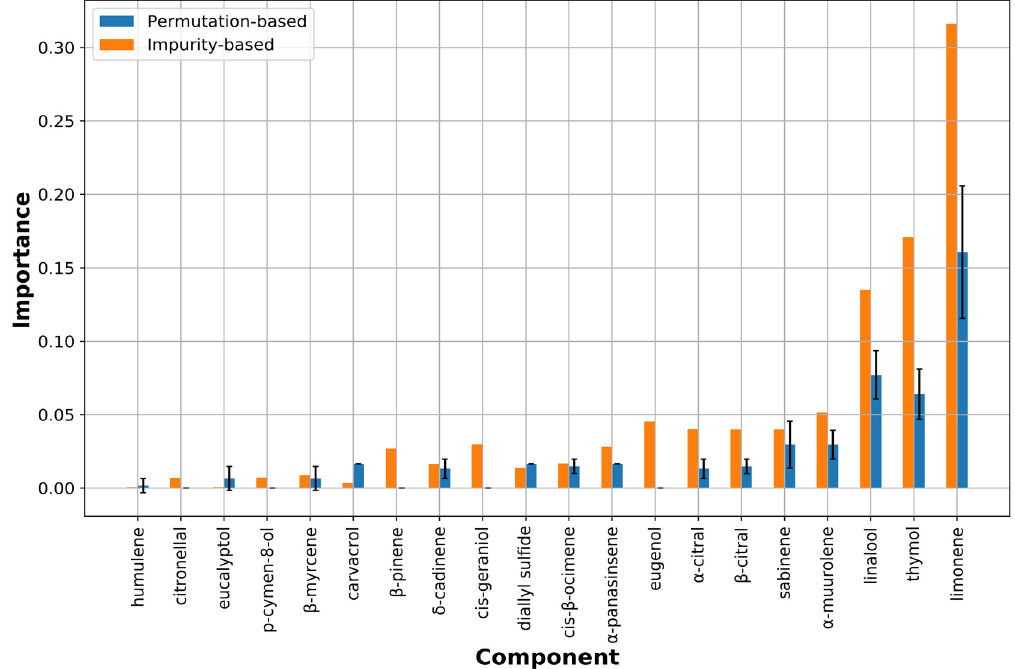
Figure 3. Feature importance (orange bars) for the 20 most important chemical components from the RF classification model applied to M. canis bioactivities. Perturbation-based importance (blue bars) is also reported using mean and standard deviation.